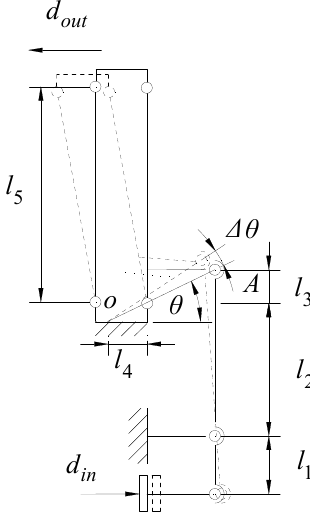
Figure 5. Pseudo rigid body model (PRBM) of double lever amplifiers.